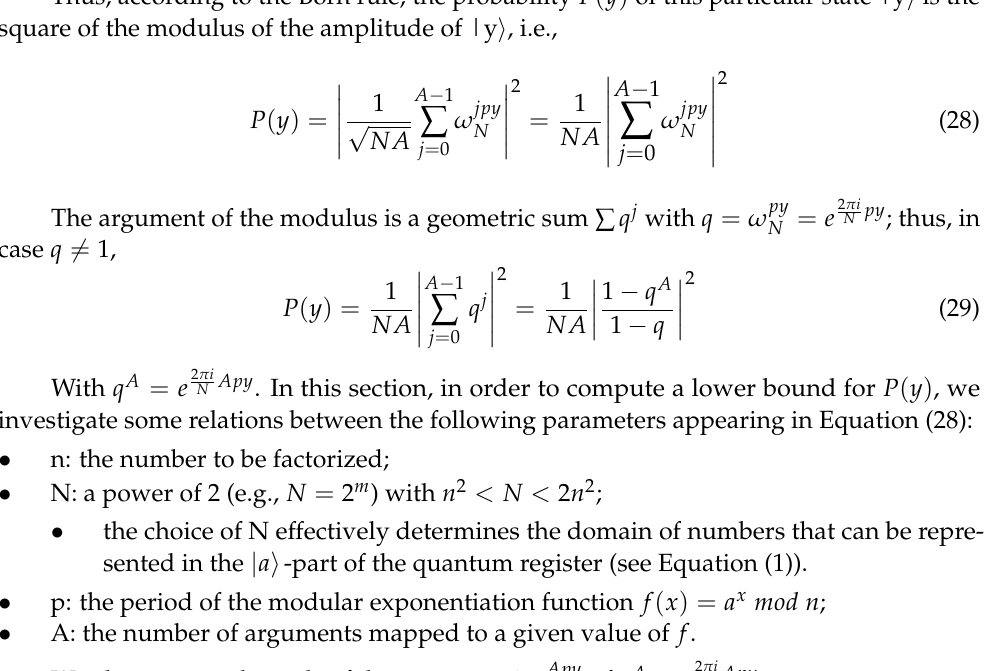
Figure 18. The graphs of sin x and 2x/ 𝜋 .